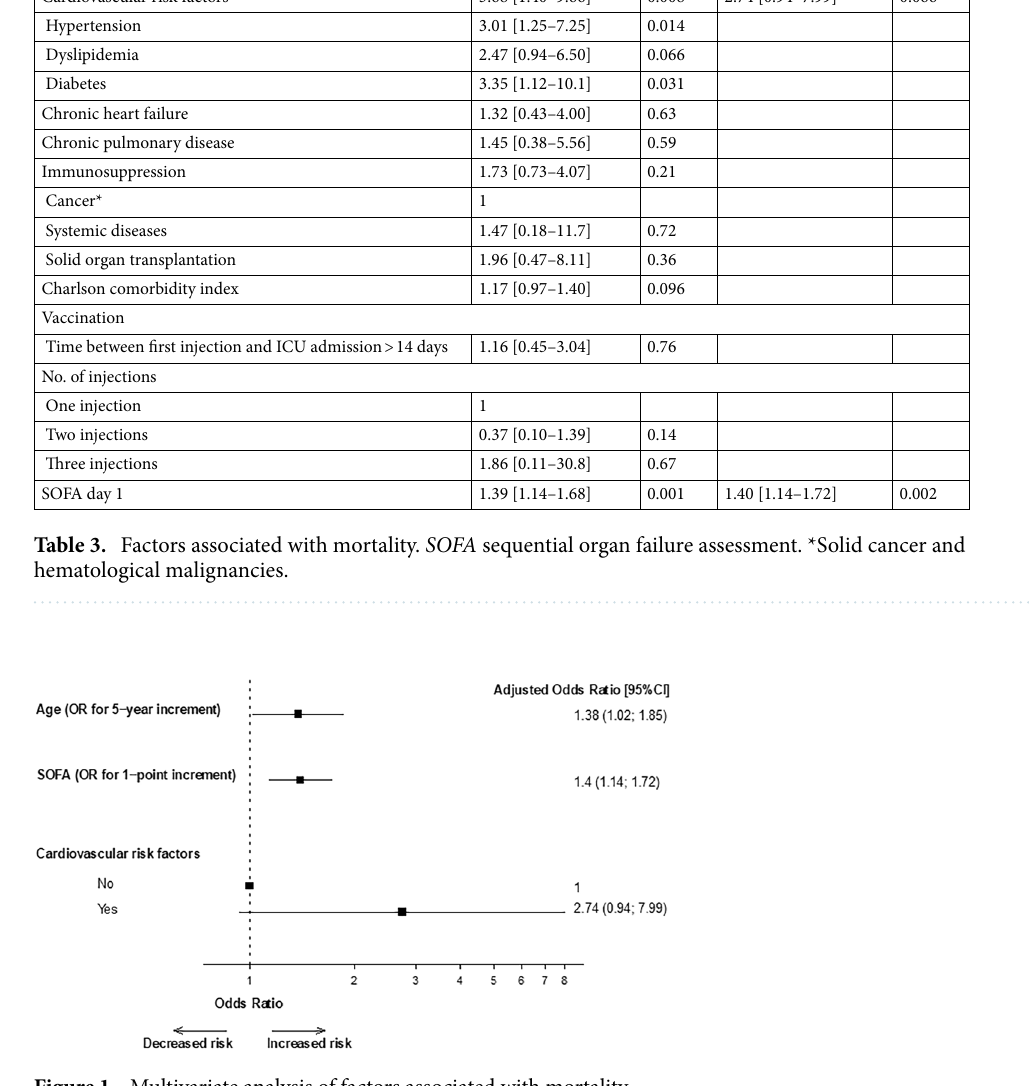
Figure 1. Multivariate analysis of factors associated with